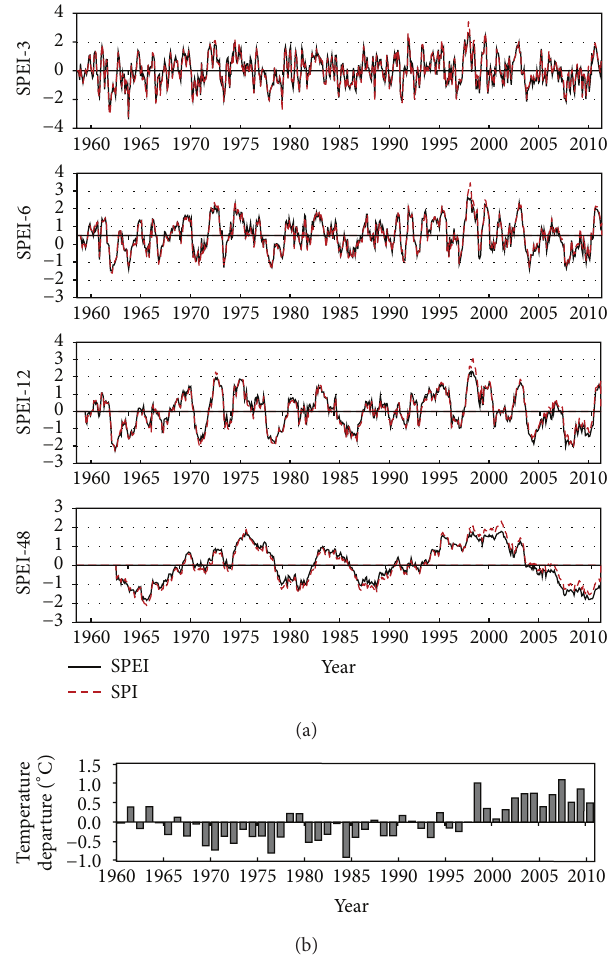
Figure 5: Evolution of multitimescale of SPEI values and major drought/flood events in the Poyang Lake catchment during 1960– 2010.